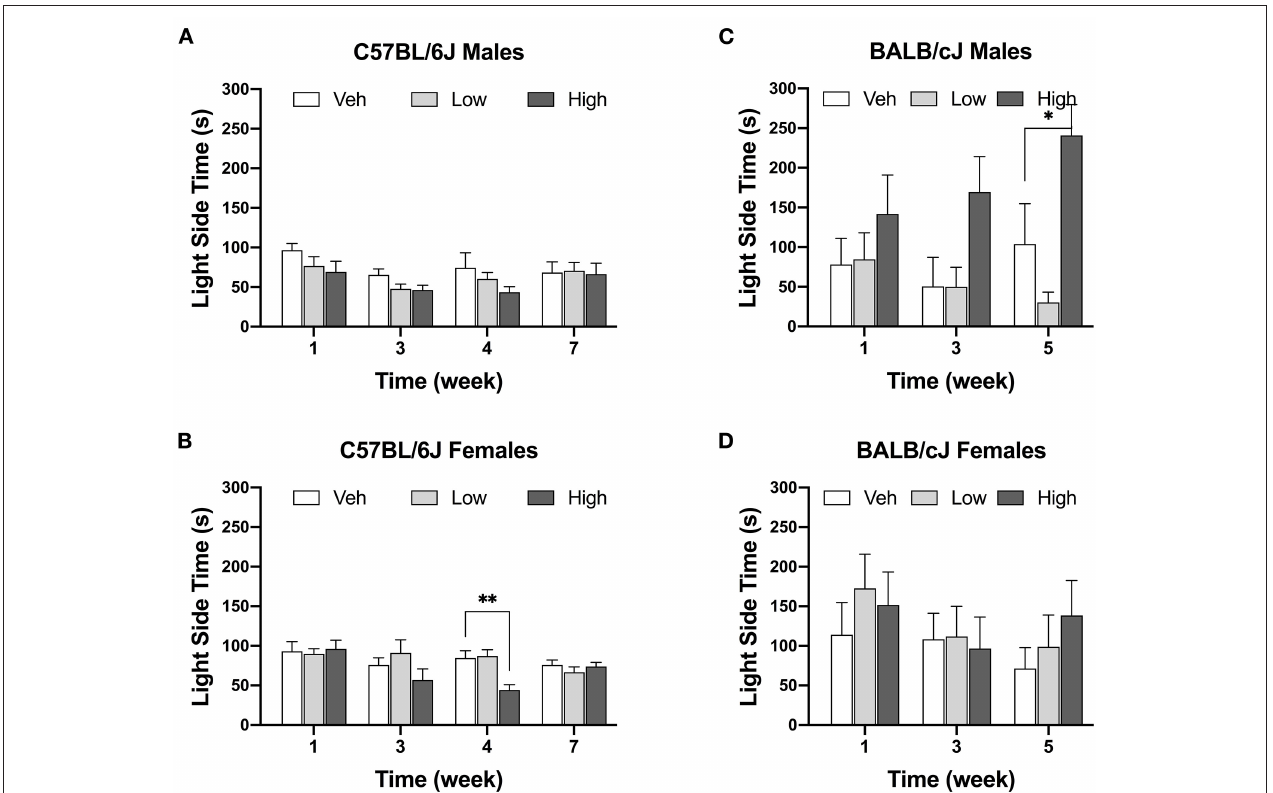
FIGURE 6 | Decrease in time spend in the light area after oxaliplatin exposure. Anxiety-like behavior was assessed in C57BL/6J males (Cohort 1, BL and week 3, n = 9/group; Cohort 2, week 4 and week 7, n = 8/group) (A) , C57BL/6J females (Cohort 1, BL and week 3, n = 9/group; Cohort 2, week 4 and week 7, n = 8/group) (B) , BALB/cJ males ( n = 7–9/group) (C) , BALB/cJ females ( n = 10/group) (D) . Values are expressed as mean ± SEM. Overall effects of oxaliplatin treatment were identified by two-way mixed-analysis model ANOVA (Treatment, Time as RM) for each strain and for each sex ANOVA with post-hoc Tukey’s multiple comparisons test, * p < 0.05; ** p <